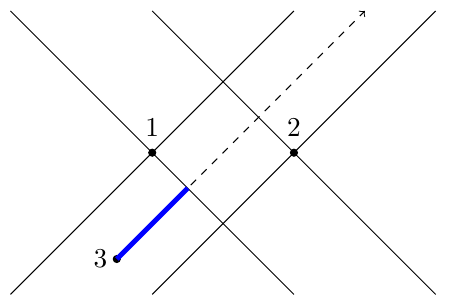
Figure 7. Causal relationships between points in the light transform (2.64). The original integra- tion contour is the union of the solid blue line and the dashed line. The solid blue line shows the region where the commutator [ (cid:30) 1 ; O ] is